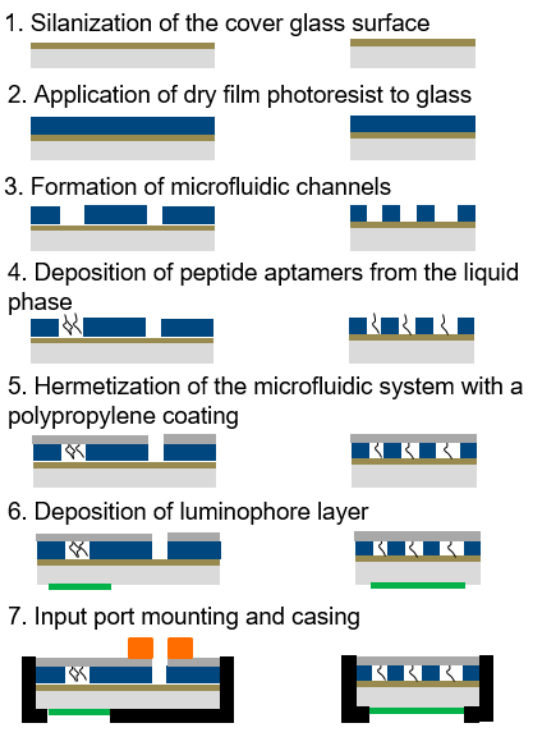
Figure 12. Diagram of the microfluidic biochip manufacturing process, including the stages of heterogeneous integration of a biorecognition element. heterogeneous integration of a biorecognition